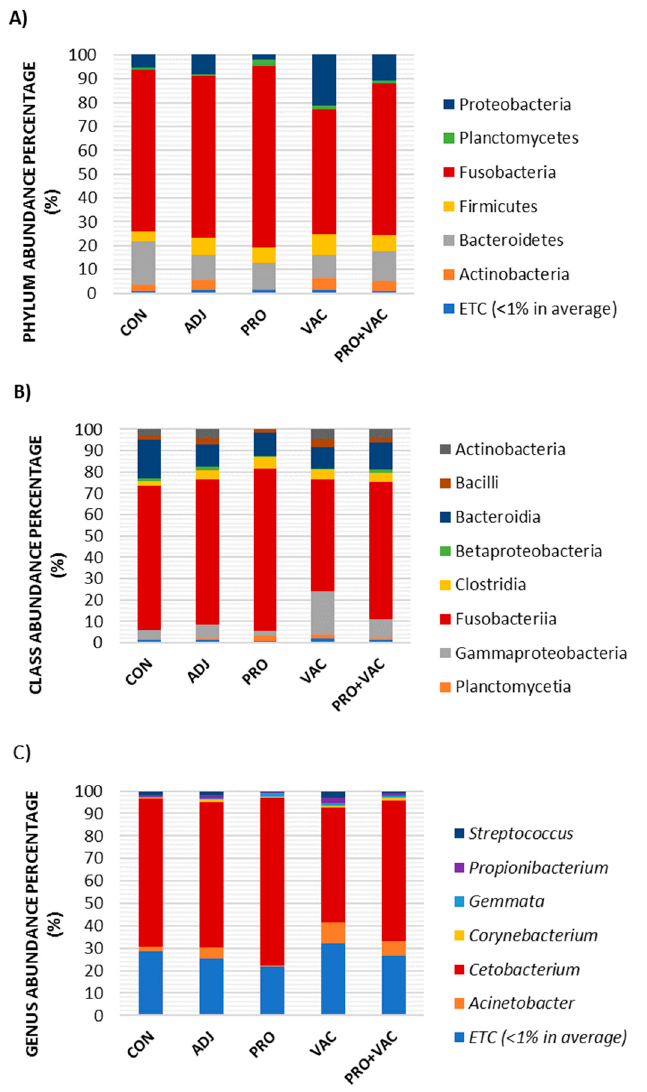
Figure 6. Intestinal microbiota composition of (OTUs, operational taxonomic units) of phylum ( A ), class ( B ), and genus ( C ) from Nile tilapia groups: CON = control; ADJ = adjuvant; PRO = probiotics; VAC = vaccinated; PRO + VAC = probiotics + vaccine).